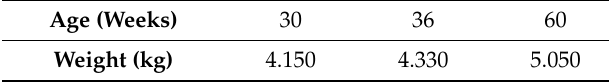
Table 1. Standard weight of breeder broiler